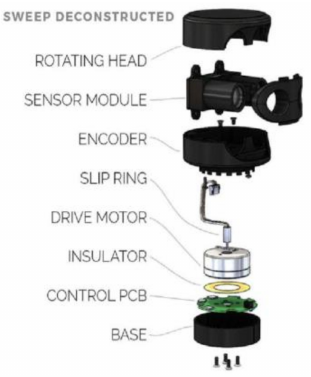
Figure A1. Exploded view of Scanse Sweep 2D LiDAR design [45].